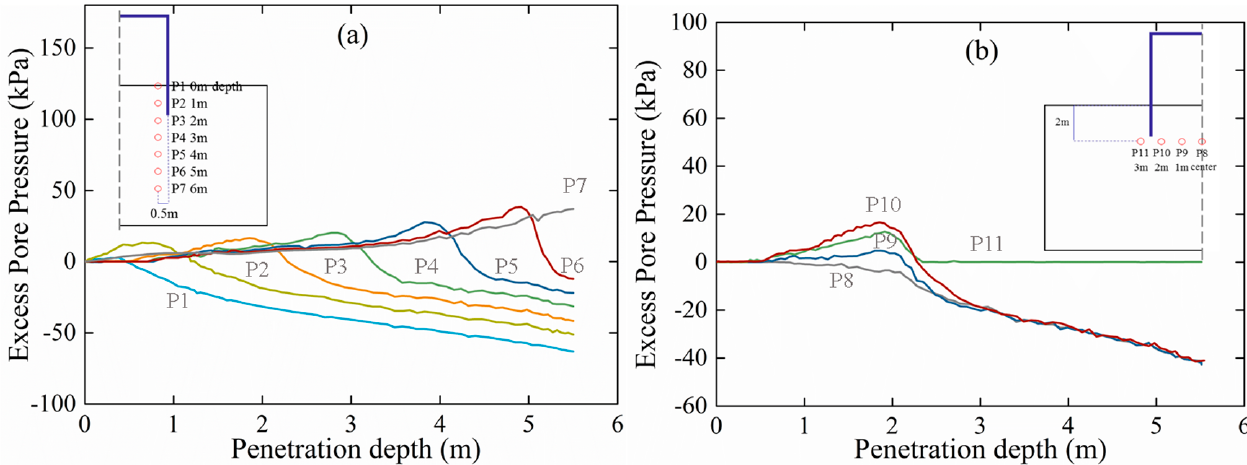
Figure 10. Excess pore pressure evolution with caisson suction penetration depth at typical points within the soil: ( a ) Points P1 to P7 at 0 m to 6 m depths 0.5 m inside the caisson wall; ( b ) Points P8 to P11 at 0 m to 3 m horizontal distances from the center of the caisson at 2 m depth.